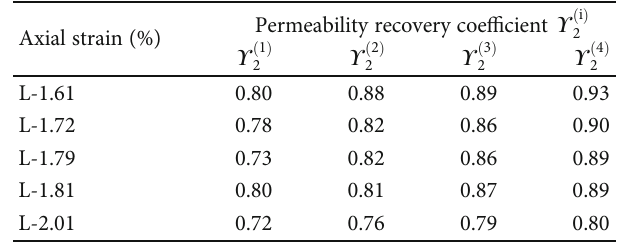
Table 14: The permeability recovery coe ffi cient of nonwater